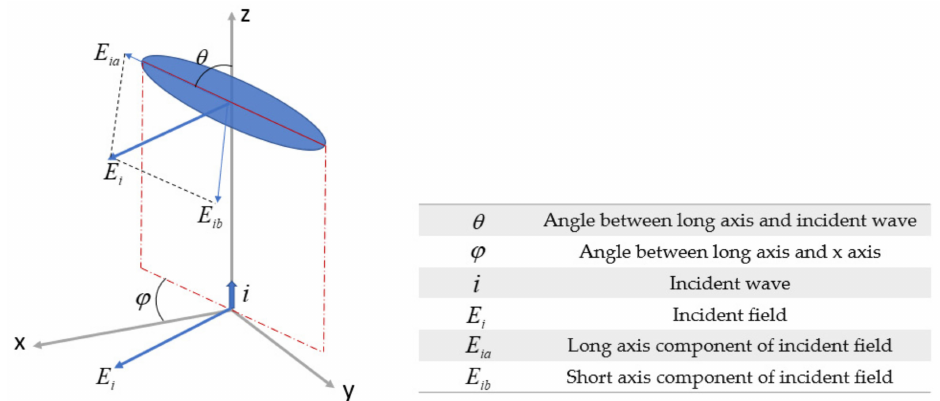
Figure 4. Schematic diagram of radar observation ellipsoid